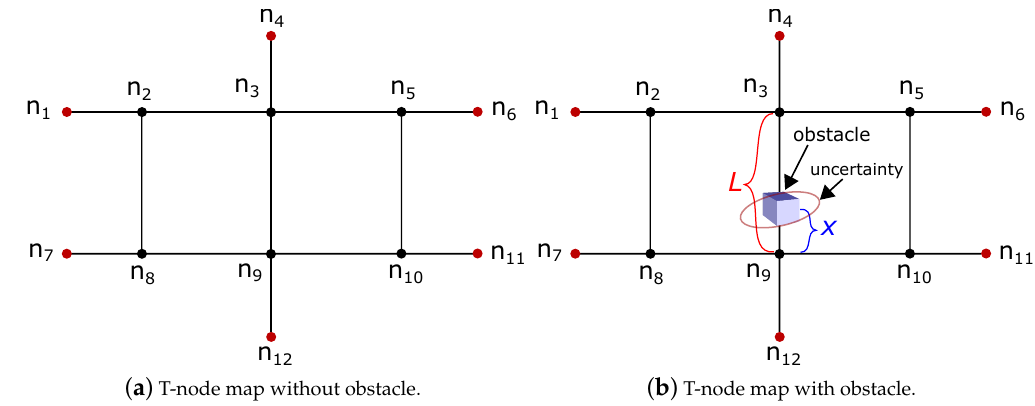
( b ) T-node map with obstacle.